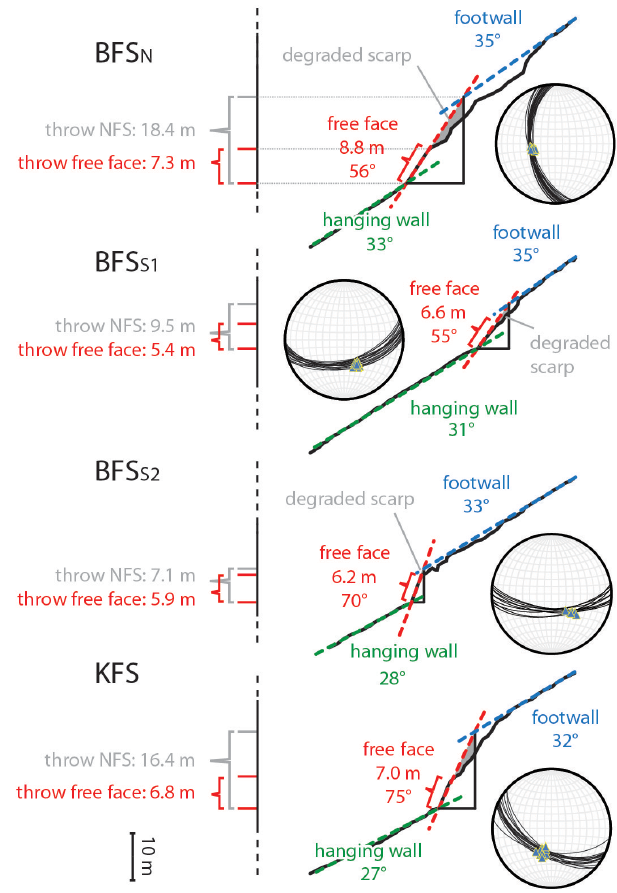
Figure 5. Profiles across the fault scarps at four selected sites (see Fig. 4 for locations). Slip rates are derived from the free-face and degraded scarp heights (compare Table S10, two right columns).